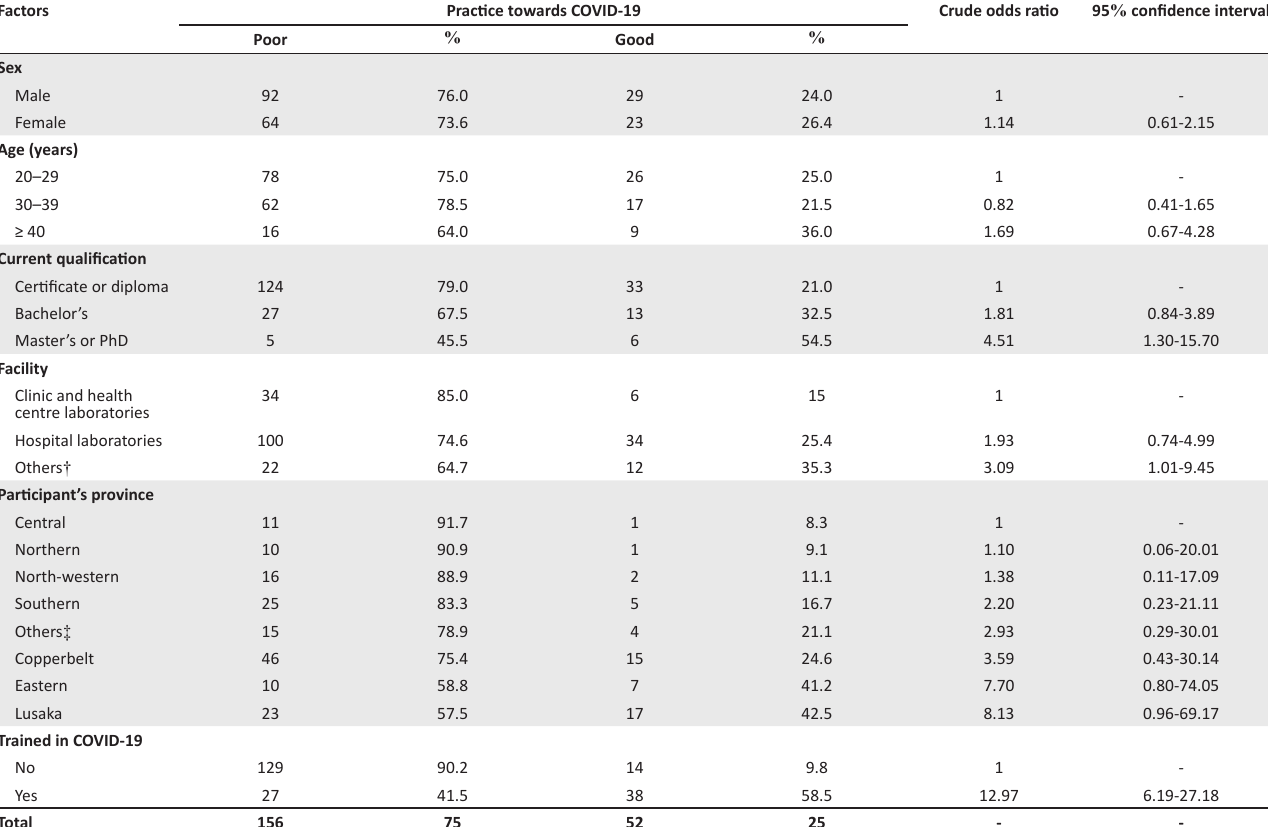
TABLE 5 : COVID-19 practices of participants and associated factors, Zambia, June 2020. Factors